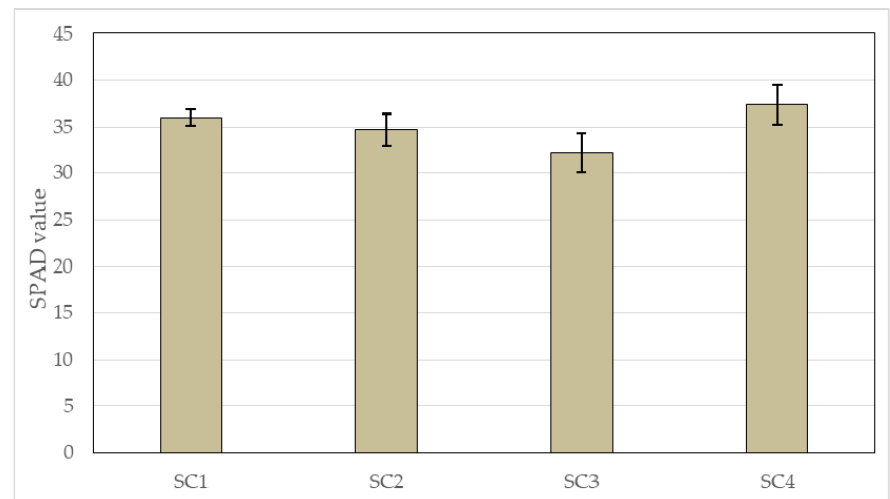
Figure 6. Mean SPAD value related to the four Substrate Compositions (SC). The bars stand for standard deviation values ( n = 4).